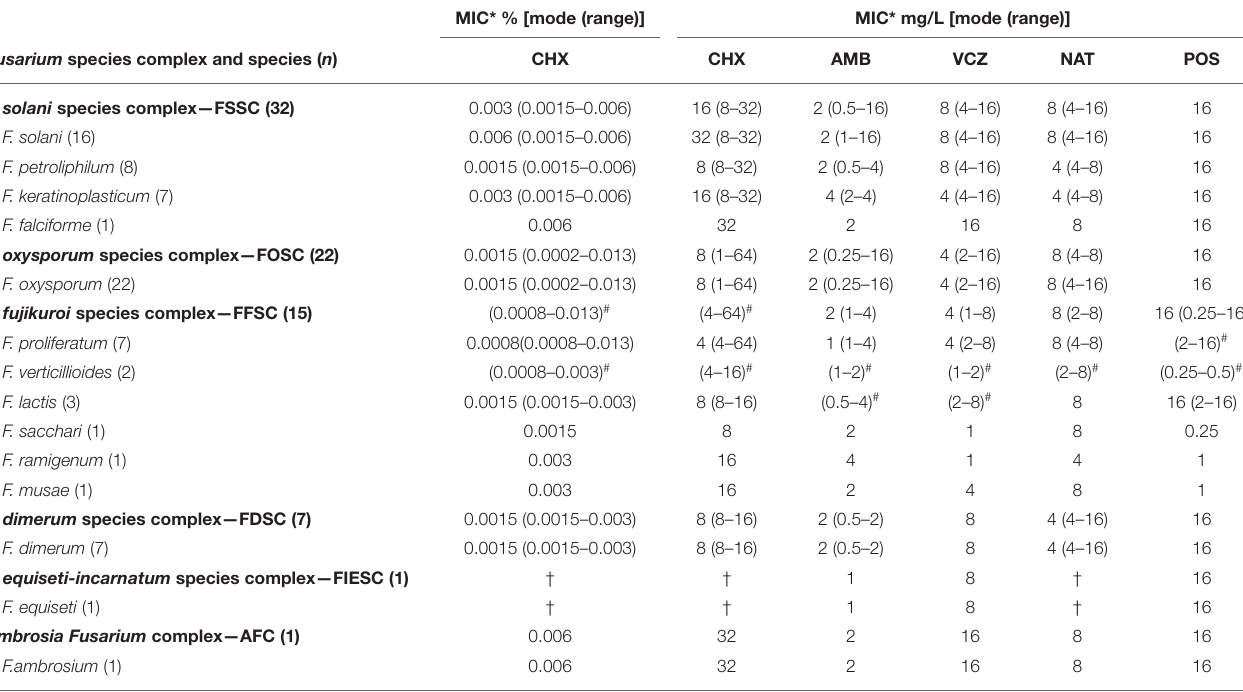
TABLE 2 | Molecularly identified fusarial keratitis isolates and their susceptibility profile including chlorhexidine (only identified strains are depicted, n = 78 and MICs presented as commonly used